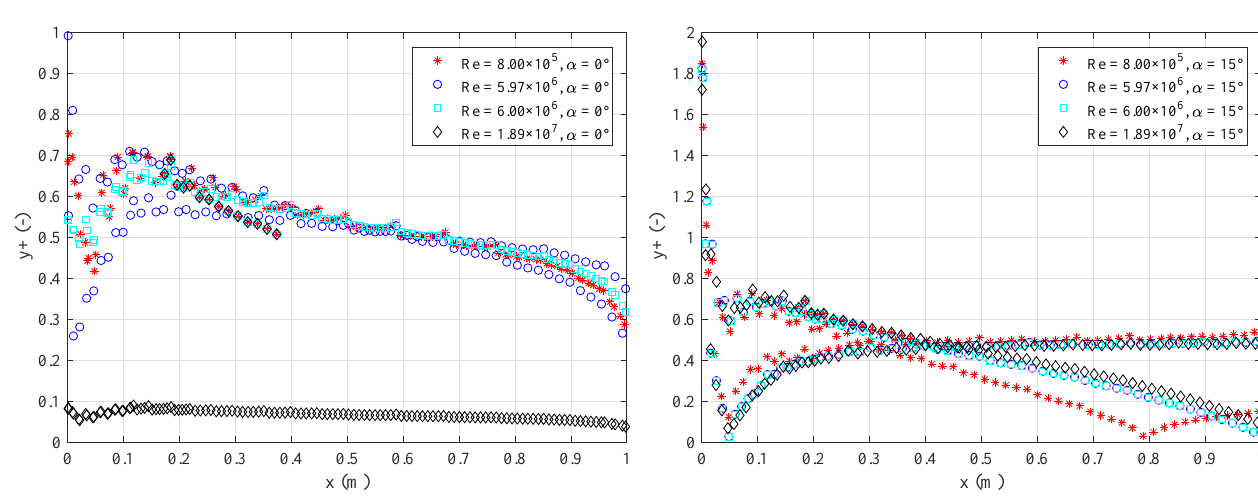
Figure 11. y + along rudder chord with varying Re